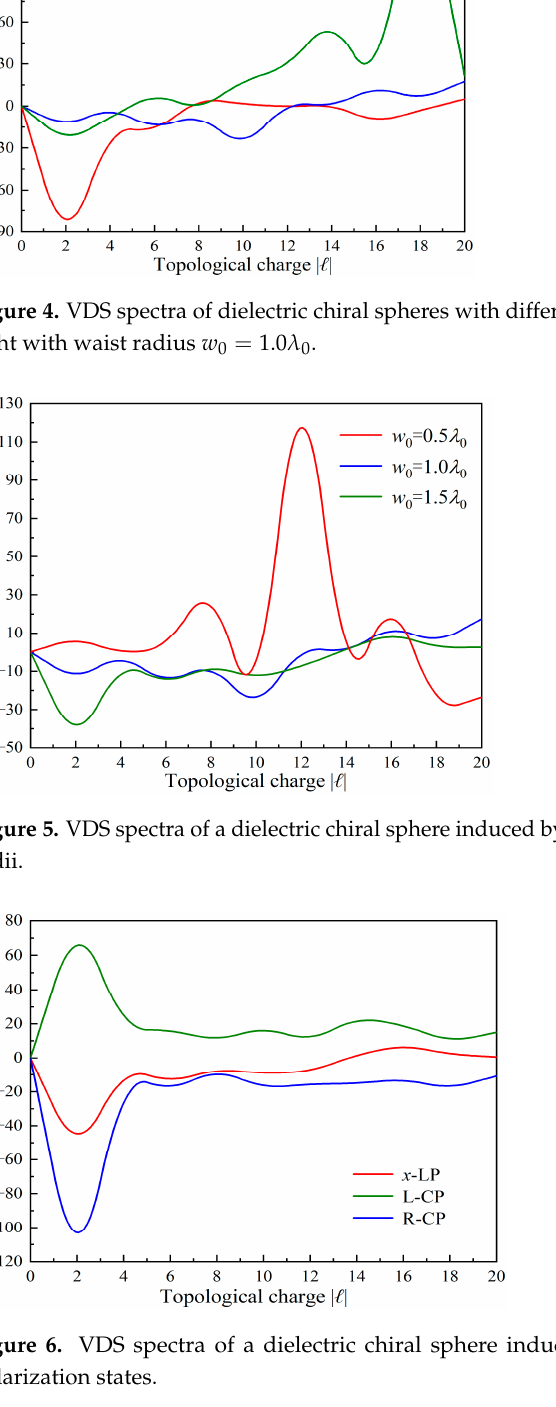
larization states. polarization